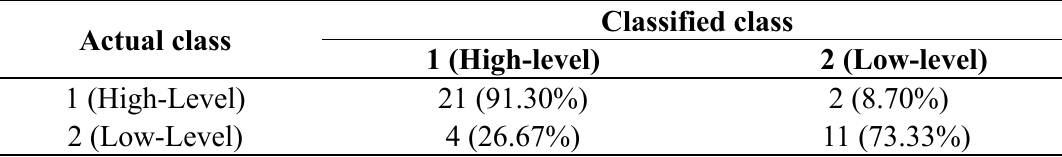
Table 5. RST-GP model (model II) results with only significant